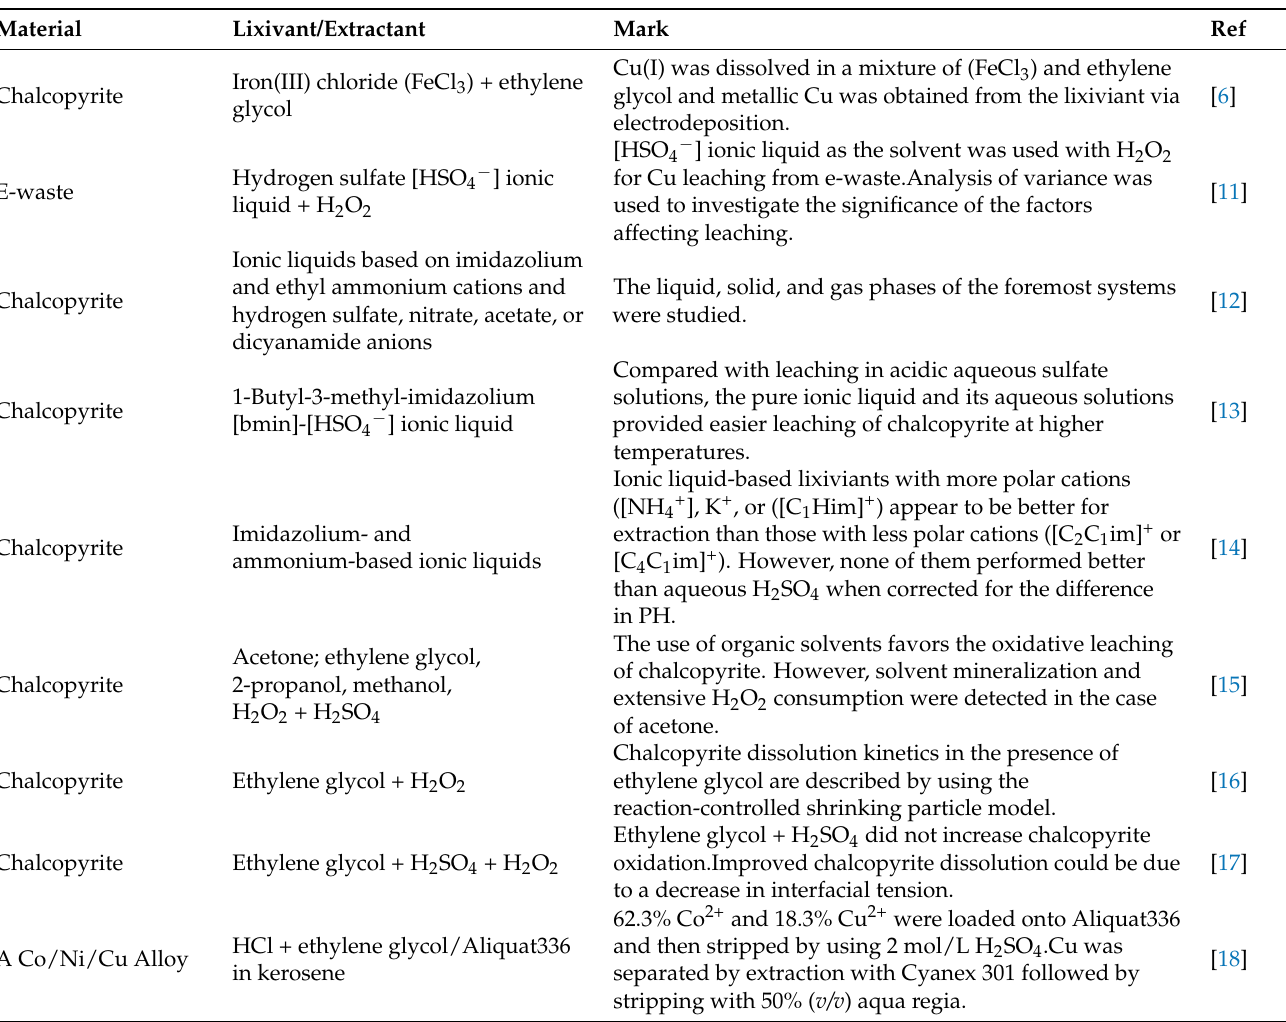
Table 1. A summary of previously reported Cu separation/recovery methods from various resources by using